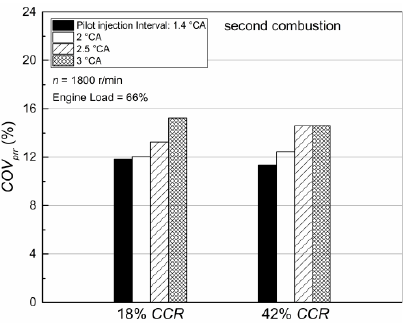
Figure 12. COV PRR of second combustion stage under different pilot injection periods.